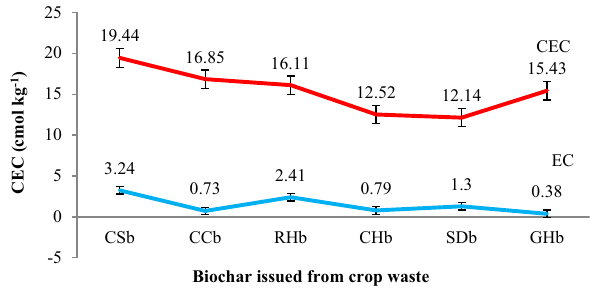
Fig. 3 Cation exchange capacity and electronic conductivity of bio- chars issued from crop wastes. CSb cassava biochar, CCb corncob